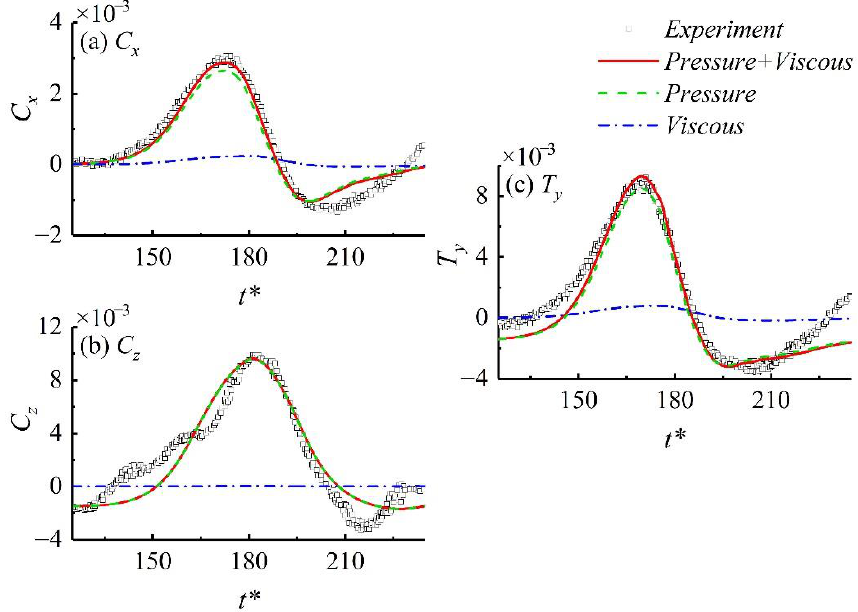
Figure 6. Forces and torques coefficients on the semi-submersible platform versus dimensionless time for Case A2.